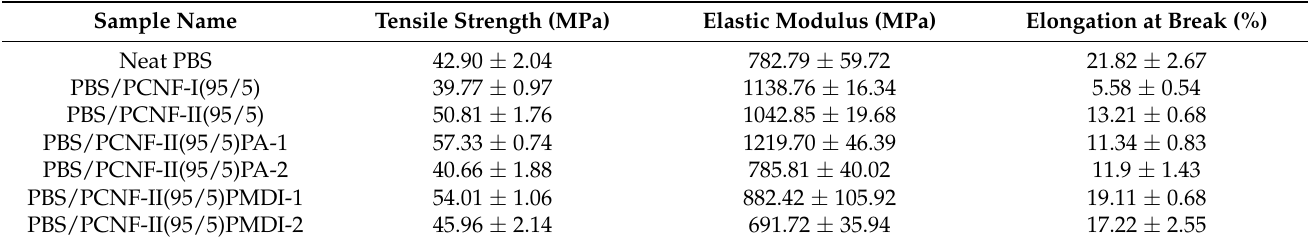
Table 4. Tensile strength, elastic modulus, and elongation at break of neat PBS and PBS/PCNF (95/5) with different coupling